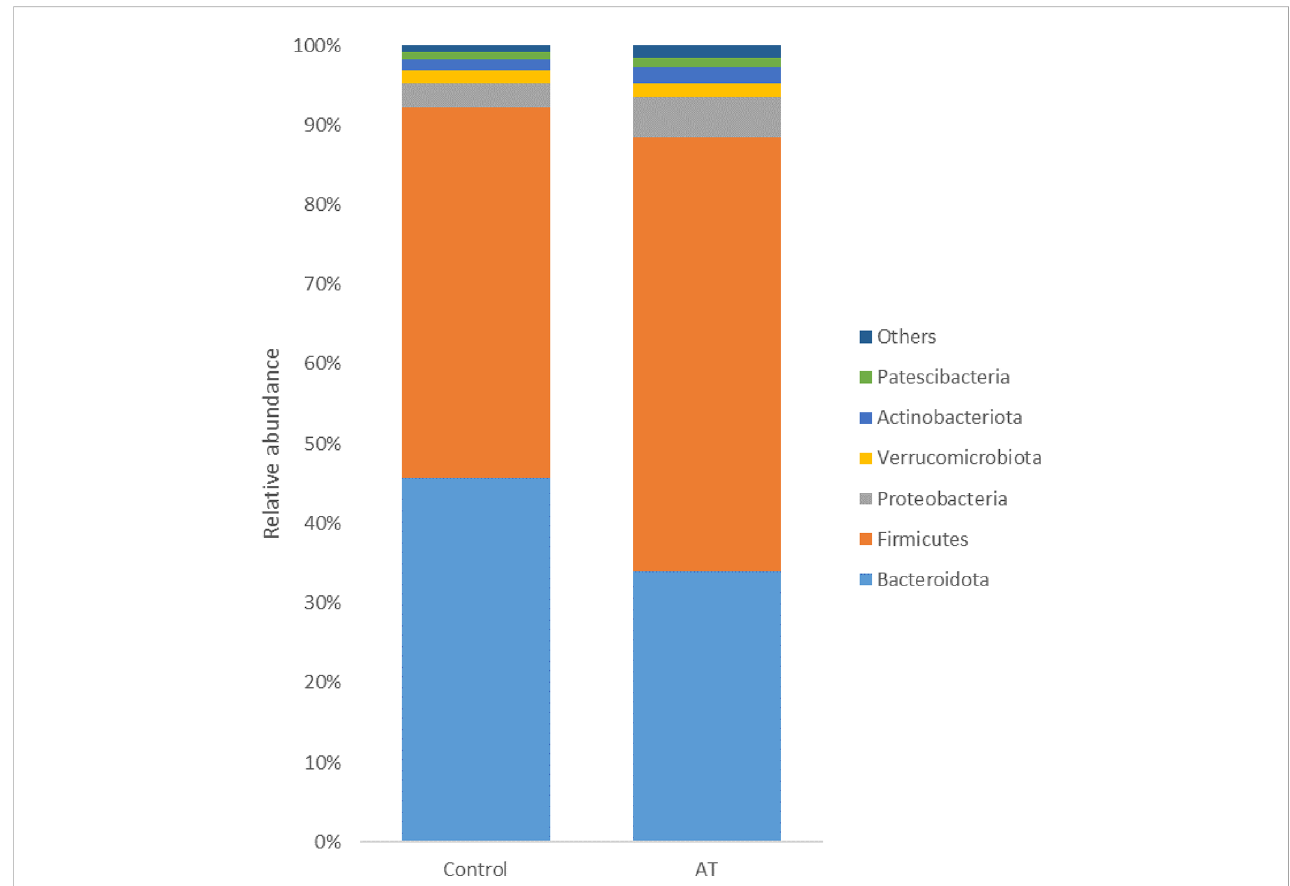
FIGURE 2 Least-squares means of relative abundance of bacteria at phylum level for cows with a diet without (control) or with supplementation with Asparagopsis taxiformis (AT). Phyla with a lower abundance than 1% are summarized as “ others ”